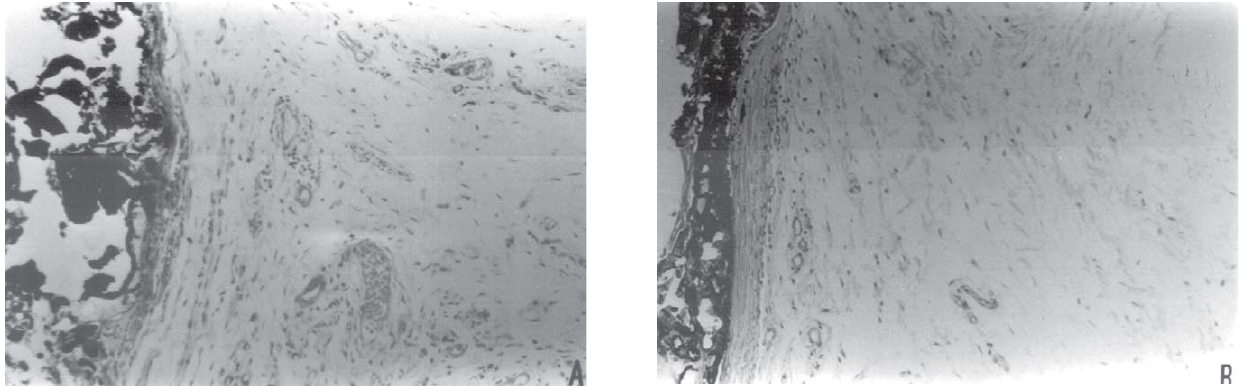
FIGURE 3- Response of the connective tissue in contact with Sealer 26 cement (arrows): 14-day experimental period (A) and 90-day experimental period (B). (40x)